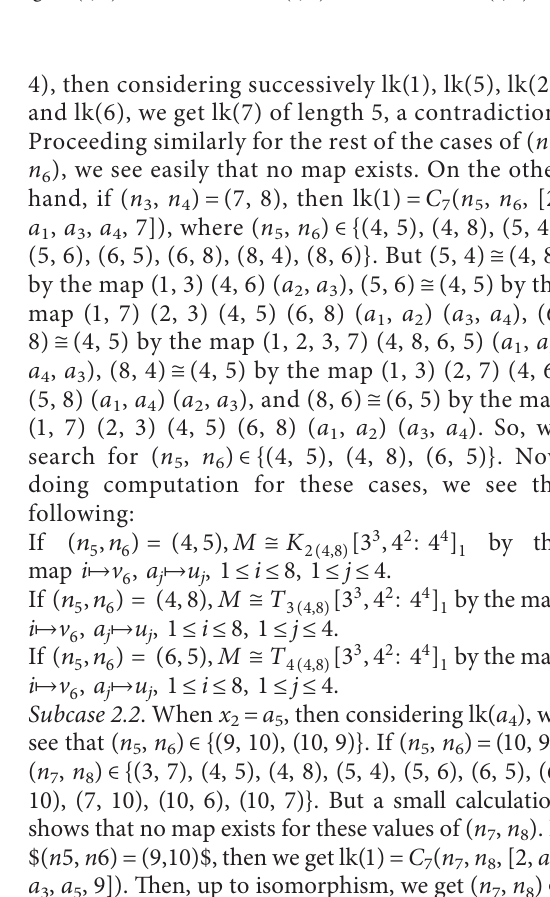
on torus and Klein bottle. (a) K 1(3,6) [3 3 , 4 2 : 4 4 ] 1 . (b) T 1(3,6) [3 3 , 4 2 : 4 4 ] 1 . (c) T 1